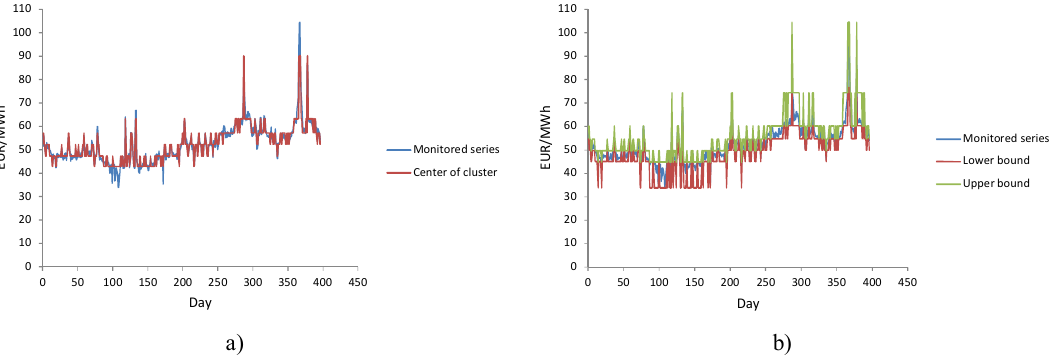
Figure 5. From monitored electricity price time series to interval-valued time series: ( a ) fuzzy time series; ( b ) interval-valued time series.